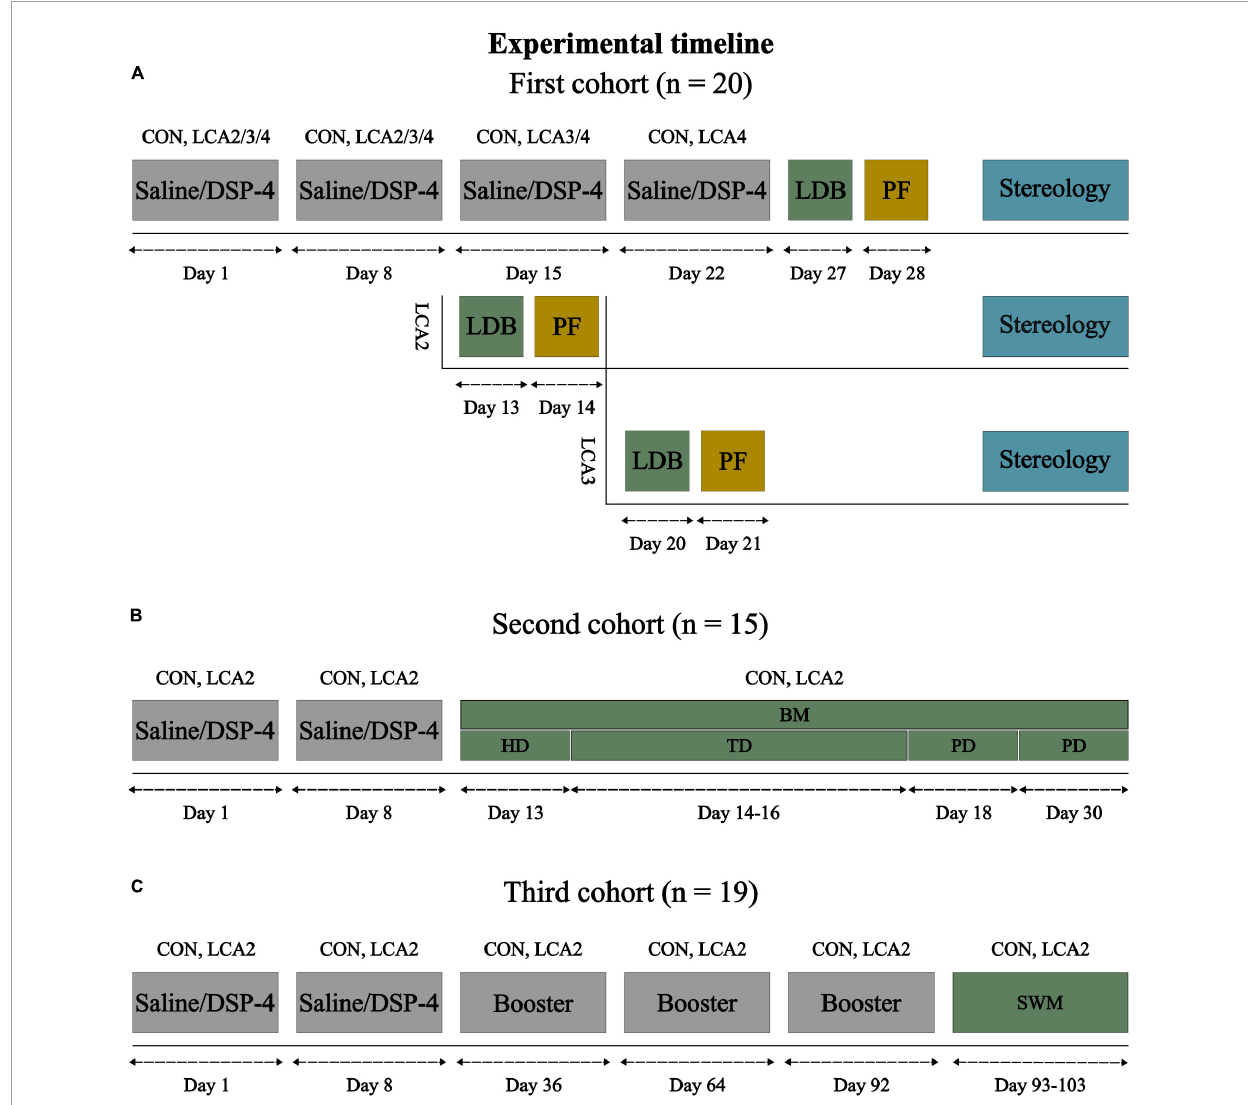
FIGURE1 Experimental timeline for each of the three cohorts of mice. (A) The first cohort of mice was divided into four groups: CON ( n = 5), LCA2 ( n = 5), LCA3 ( n = 5), and LCA4 ( n = 5), receiving four saline, two DSP-4, three DSP-4, and four DSP-4 injections, respectively. All groups underwent the LDB test 5 days after the last injection. The brain tissue was perfusion fixated 1 day after the LDB test and prepared for stereology. (B) Based on the results of the first cohort, the second cohort was divided into a CON group ( n = 8) and an LCA2 group ( n = 7). These groups underwent the BM test consisting of six test days. The mice explored the BM table for 3 min during the first day (HD), in which the escape box and visual cues were removed. During the following three TDs, each mouse underwent three trials per day of 3 min or until they entered the escape box with three visual cues on the walls. The two PDs consisted of one trial of 3 min in which the escape box was removed. (C) The last cohort of mice was divided into a CON group ( n = 10) and an LCA2 group ( n = 9). The groups underwent non-invasive sleep-wakefulness monitoring (SWM) approximately 3 months after the two initial injections. Meanwhile, the CON and LCA2 groups received three booster injections of saline or DSP-4, respectively. Each SWM session lasted for 24 h. LDB, light-dark box; BM, Barnes maze; HB, habituation day; TD, training day; PD, probe day; SWM, sleep-wakefulness monitoring; PF, perfusion